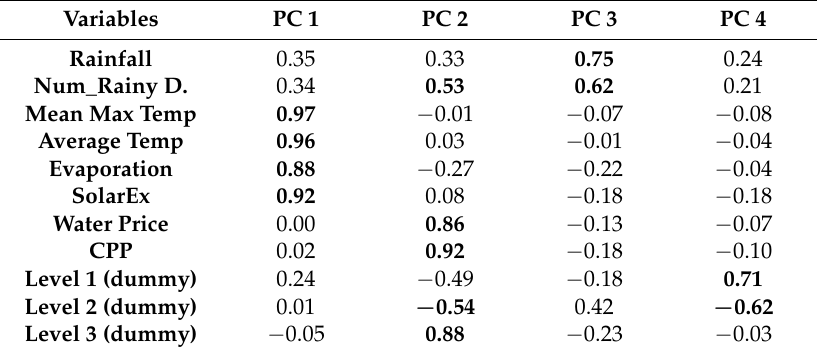
Table 3. Variable loadings (correlations between original variables and the first four PCs).